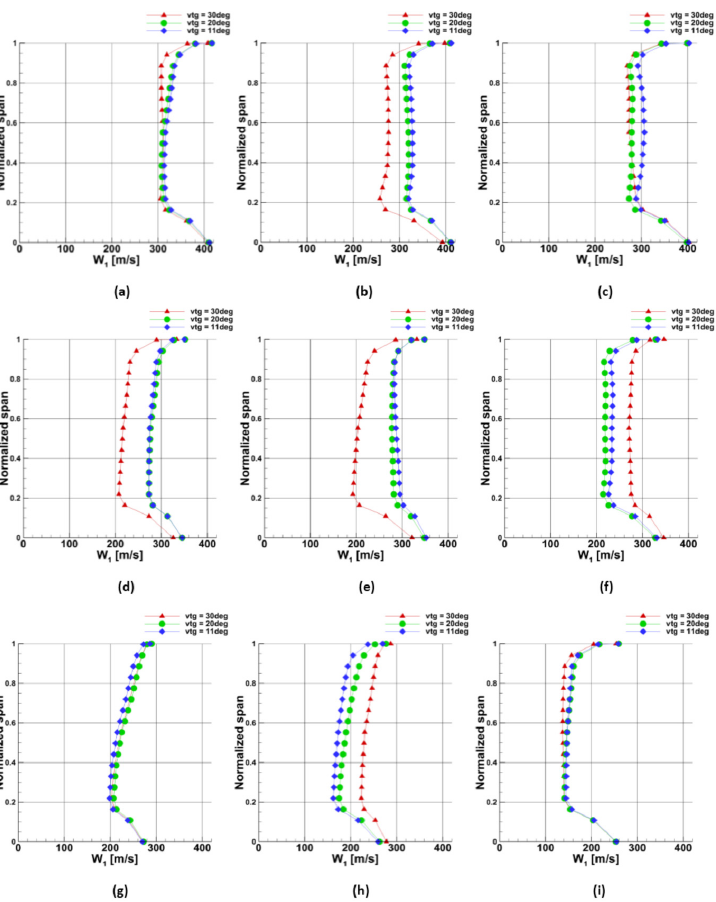
Figure 28. The plots of the relative velocity W 1 measured behind the 1st stage nozzle vane against the blade height for: ( a – c ) 60,000 rpm point A, B, C respectively, ( d – f ) 50,000 rpm point A, B, C respectively, ( g – i ) 40,000 rpm point A, B, C respectively.